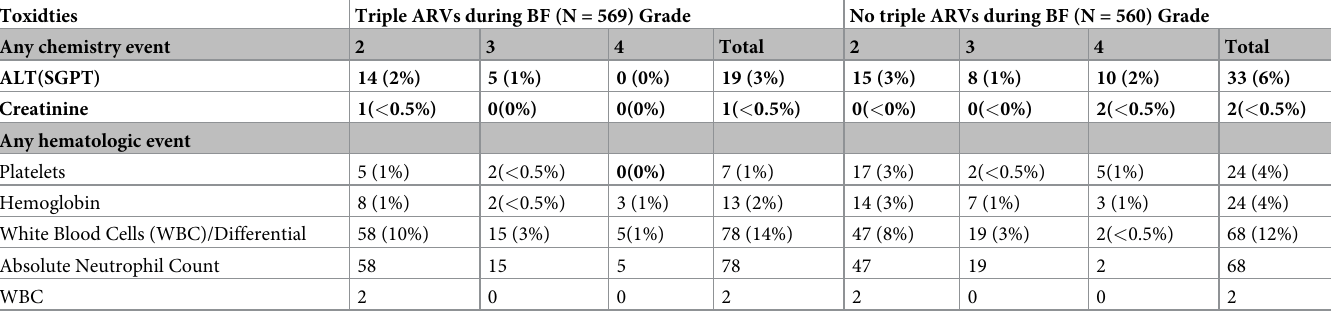
Table 3B. Laboratory adverse events for the PP-only analysis group.